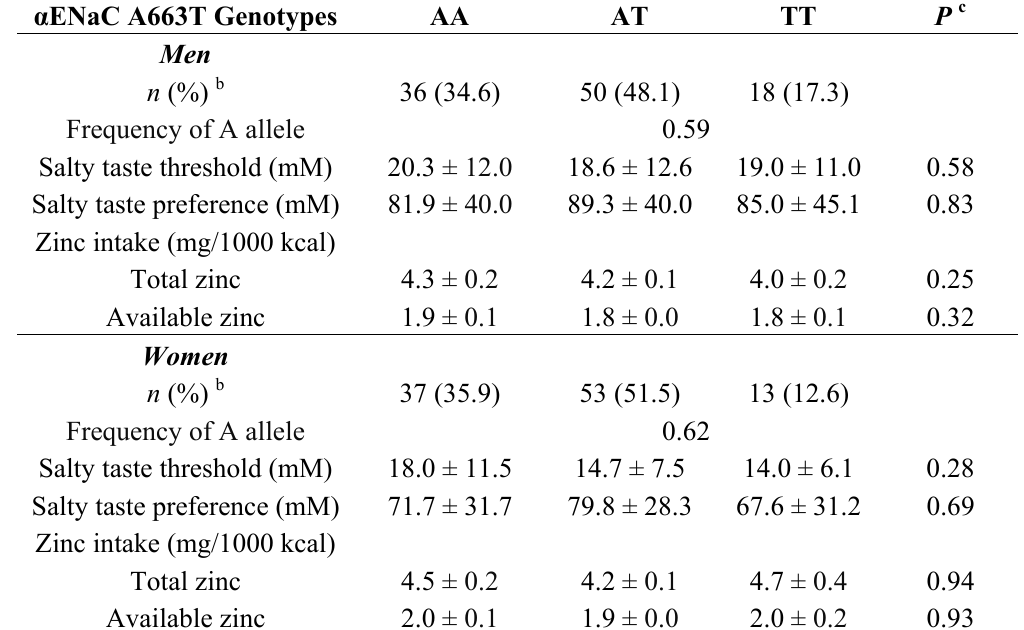
Table 2. Salty taste threshold and preference and zinc intake by α ENaC A663T genotype in men and women a